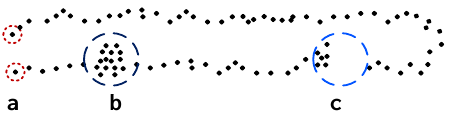
Figure 2. The different types of stop points. ( a ) Type I; ( b ) Type II; ( c ) Type Figure 2 . The different types of stop points. ( a ) Type I; ( b ) Type II; ( c ) Type III.